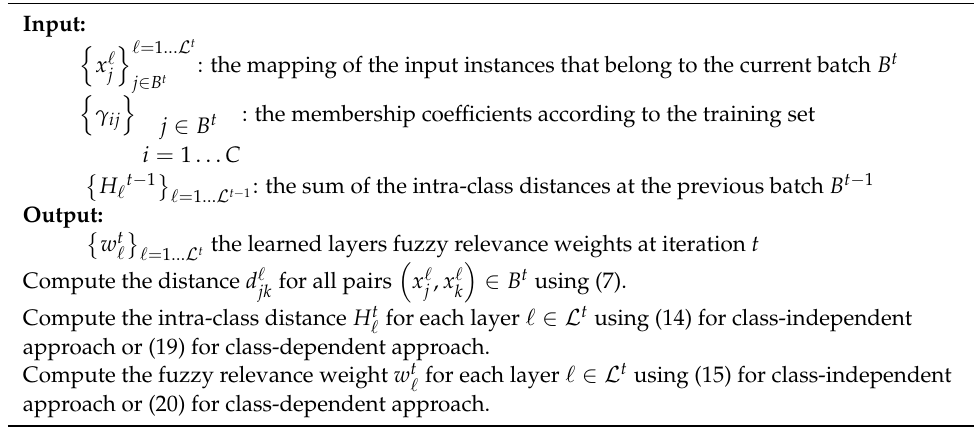
Algorithm 1: Layer Fuzzy Relevance Weight Learning Algorithm